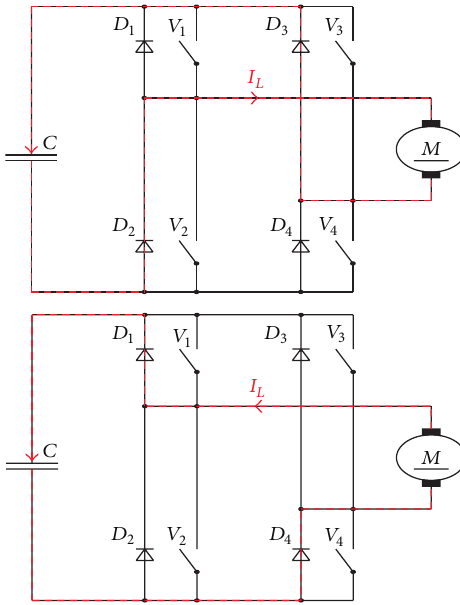
Figure 8: Phase five: capacitor charging phase.